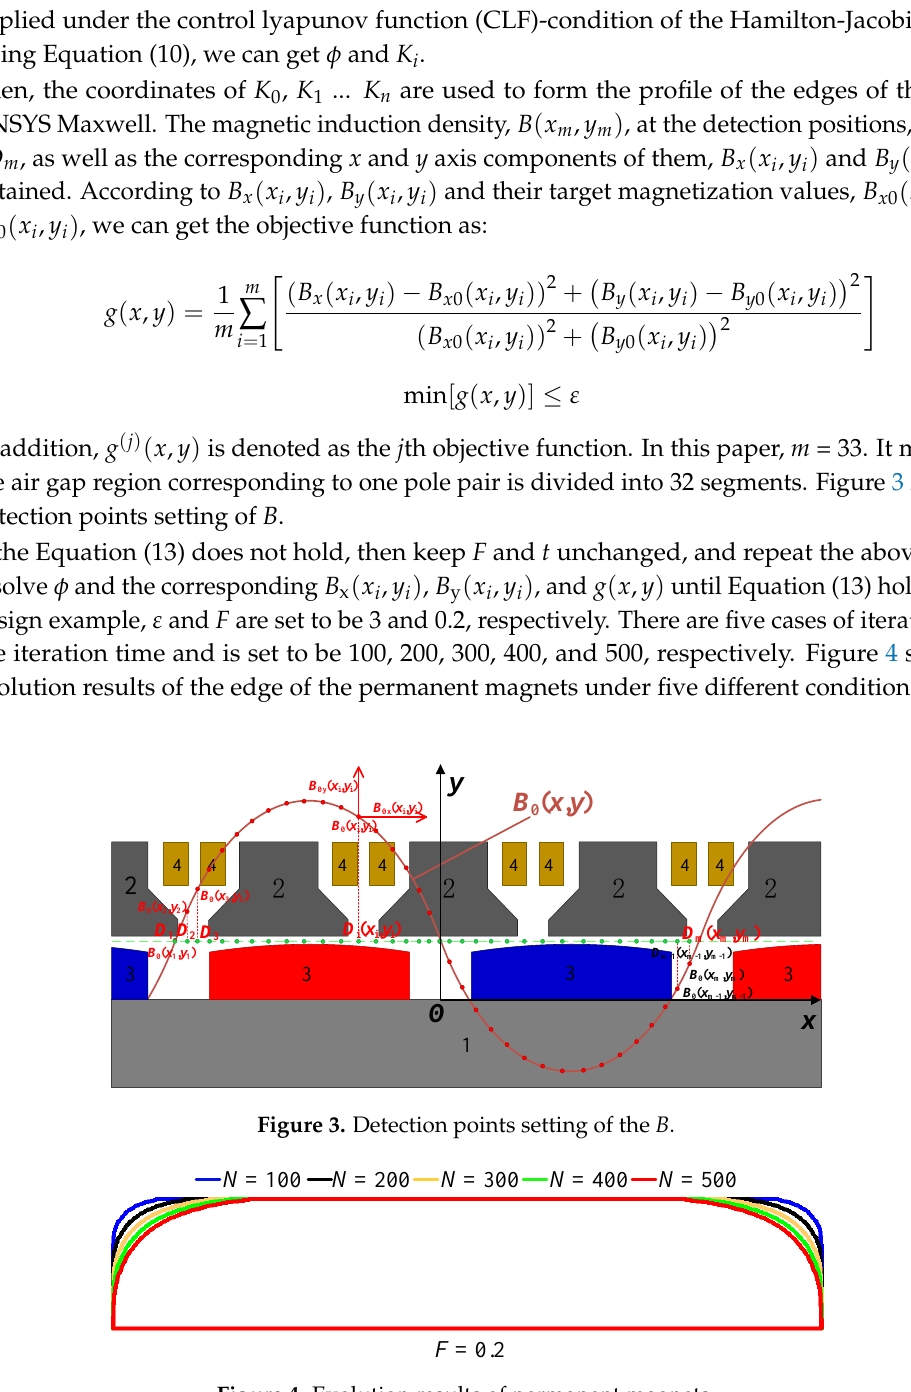
Figure 4. Evolution results of permanent magnets.